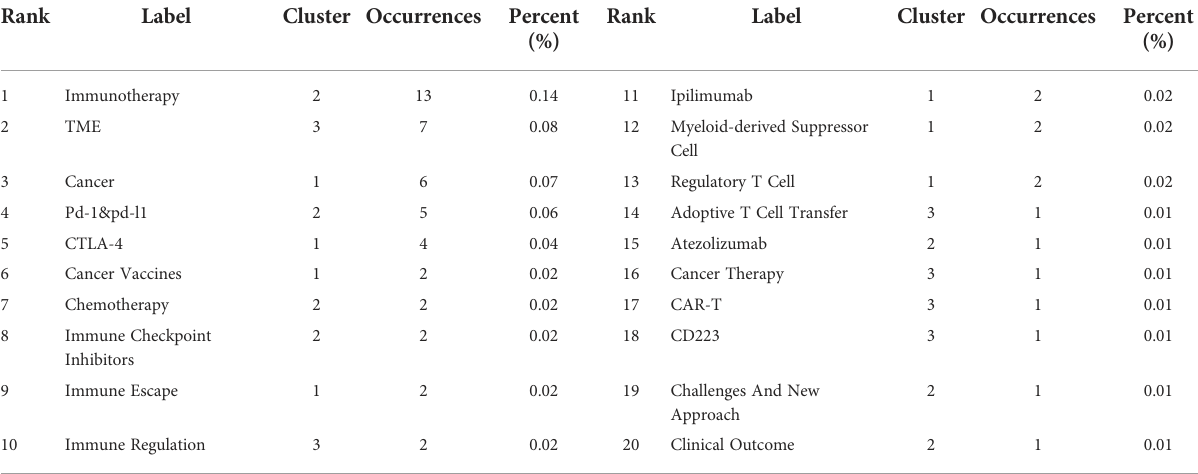
TABLE 9 The top 20 keywords of top100 cited articles research.